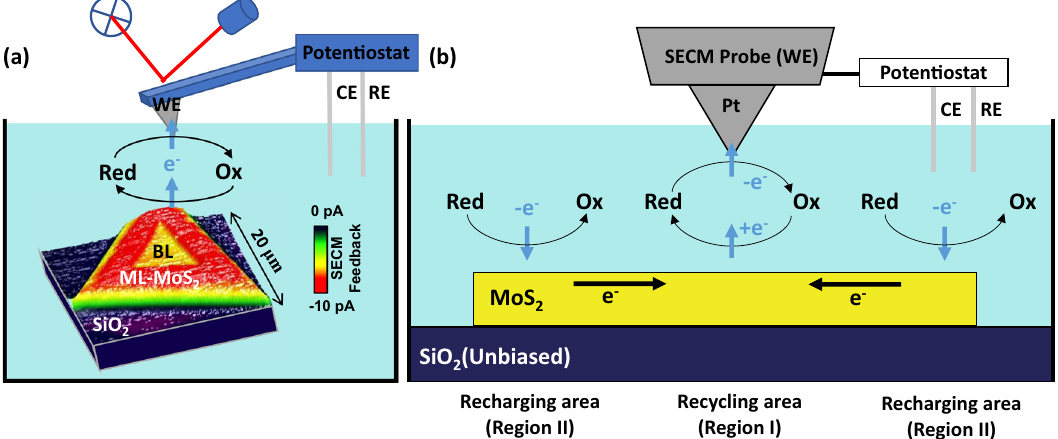
Fig. 1 Probing the heterogeneous electron transfer at the MoS 2 -liquid interface via nanoscale redox mapping. a AFM-SECM setup with the MoS 2 /SiO 2 system, formed of monolayer (ML) and bilayer (BL), immersed in a decamethylferrocene (DmFc) redox mediator electrolyte. For SECM experiments with an unbiased sample, the applied potential at the SECM probe (the working electrode, WE) is controlled by a three-electrode system with a Pt wire as the counter electrode (CE) and a Ag wire the reference electrode (RE). The color of the SECM current map encodes the measured feedback current as fl owing through the probe (Scan rate: 20 µ m/s, V WE-RE (Ag) : 0.2 V, DmFc mediator). b In Region I, recycling of the mediator (curved arrows) from oxidant (Ox) to reductant (Red) carries the feedback with charge neutrality maintained by recharge through Region II. Respectively, electrons fl ow at the interface (blue arrows) and between the recharging and the recycling area (black arrows). The light blue area represents the redox mediator electrolyte, the yellow area the MoS 2 fi lm, and the dark blue area the SiO 2